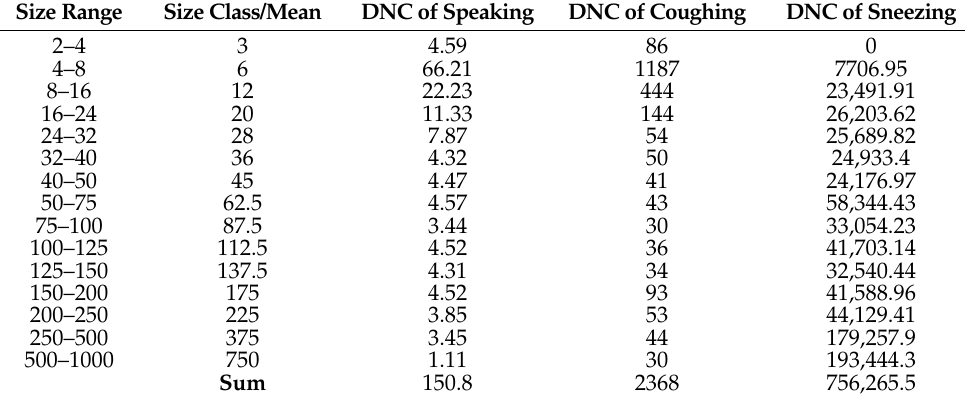
Table 5. Characteristics of the cough and sneeze cases for sensitivity investigations